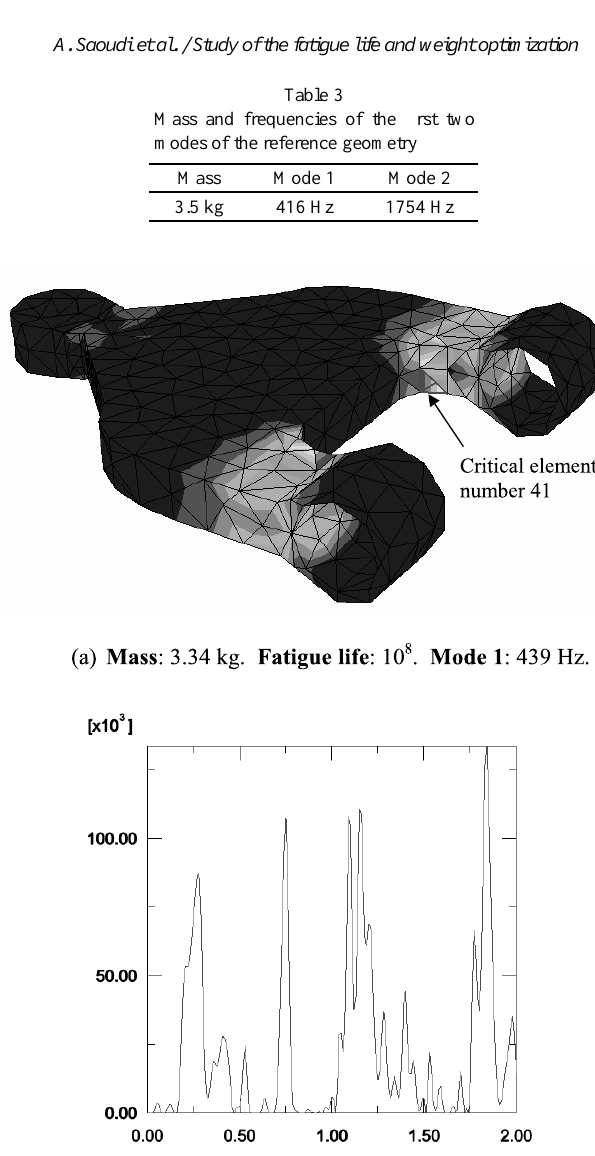
Fig. 8. First optimization